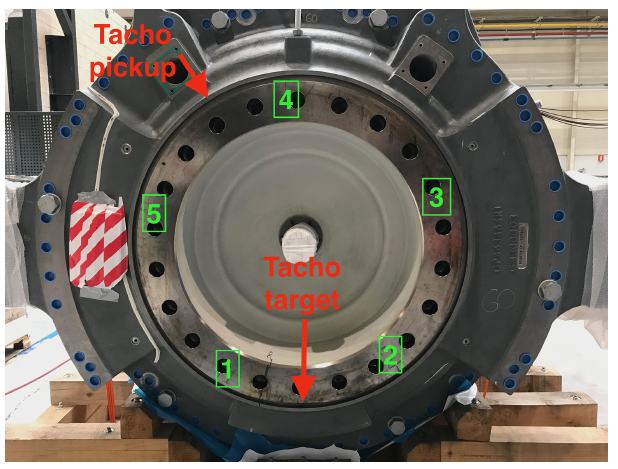
Figure 4. Position of planets and input shaft marker, stationary in- ductive sensor, and rotating target. Tacho is short for